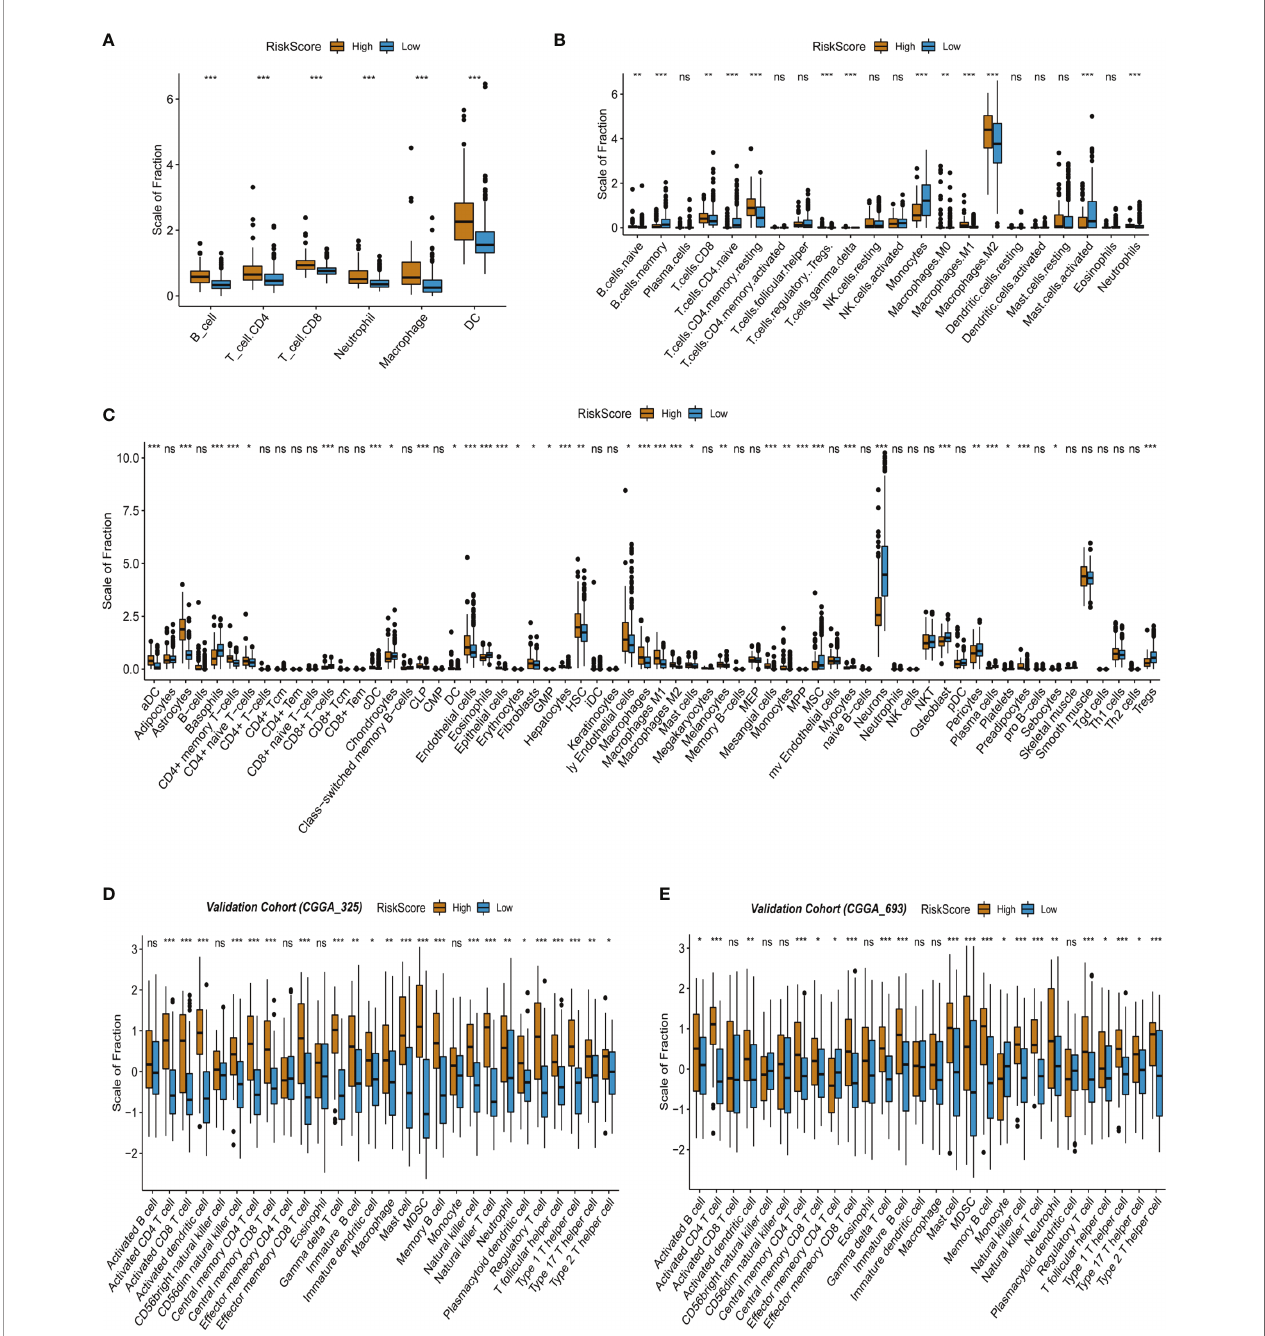
FIGURE 5 | In fi ltrated immune cells in the high- and low-risk score group from the training and validation cohorts. (A) Immune in fi ltrates in the two groups based on the TIMER algorithm from TCGA-LGG cohort. (B) Immune in fi ltrates in the two groups based on the CIBERSORT algorithm from TCGA-LGG cohort. (C) Immune in fi ltrates in the two groups based on the xCell algorithm from TCGA-LGG cohort. (D) Immune in fi ltrates in the two groups based on the ssGSEA algorithm from the validation cohort (CGGA 325). (E) Immune in fi ltrates in the two groups based on the ssGSEA algorithm from the validation cohort (CGGA 693). "*" means 0.01<p<0.05, "**"means 0.001<p<0.01, "***"means p<0.001, "ns"means no signi fi application in prognosis judgment. Firstly, multivariate Cox (TRF) risk score ( Figure 7A ). The Tumor Recurrence Factor risk regression analysis was performed for determining the score and Age were found to be relatively signi fi cant independent independent prognostic factors of Histology, Grade, prognostic factors (p < 0.001), followed by IDH.status (p = 0.055) IDH.status, X1p.19q.codel, Age, and Tumor Recurrence Factor ( Figure 7D ). After that, a nomogram was constructed based on